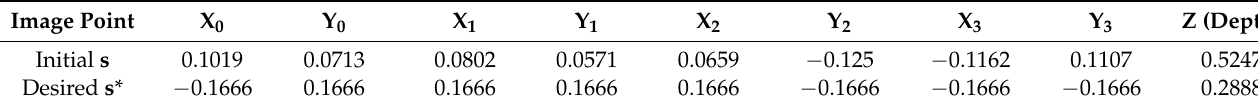
Table 2. Image points feature list for the IBVS Experiment-1.